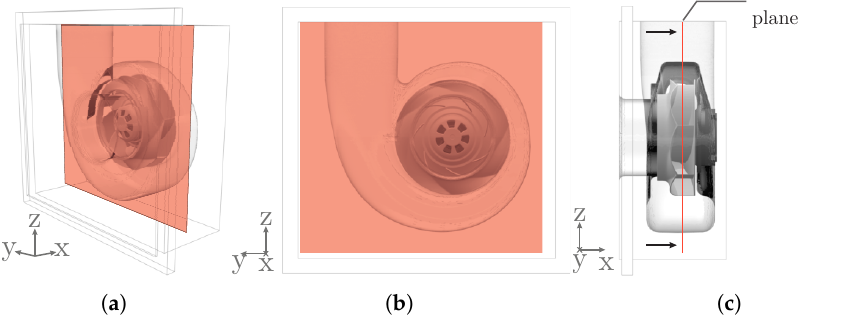
Figure 11. Illustration of the impeller and housing in gray and the evaluation plane through the center of the impeller in red as isometric view ( a ), in x -direction ( b ) and y -direction ( c ); the black arrows in ( c ) indicate the viewing direction.